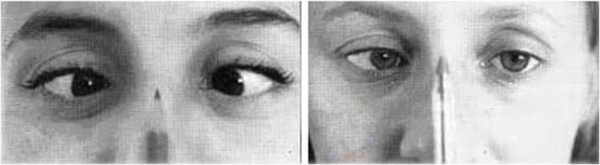
Convergence test.